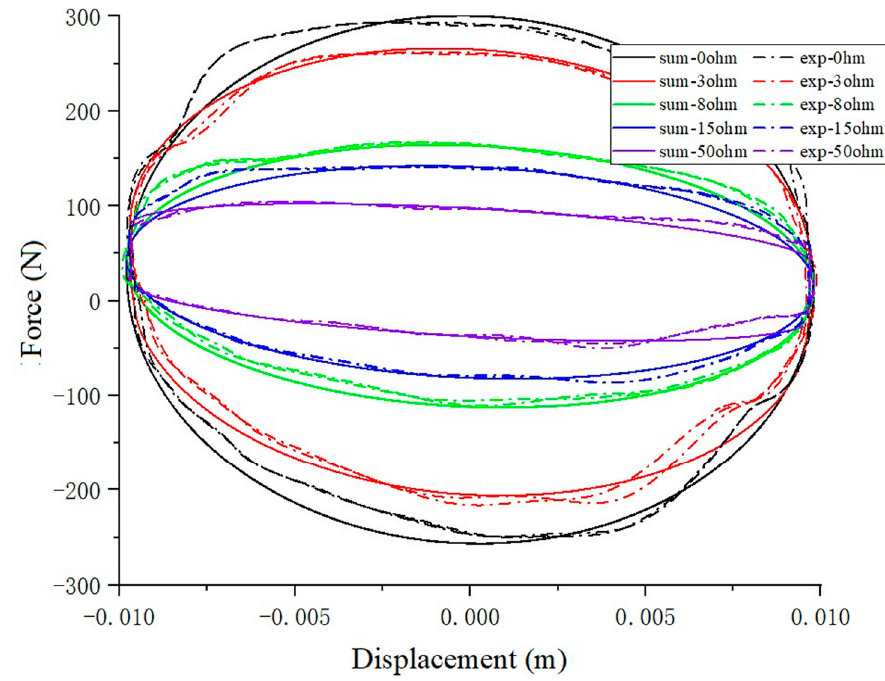
Figure 9. Force-displacement characteristics of VD device.